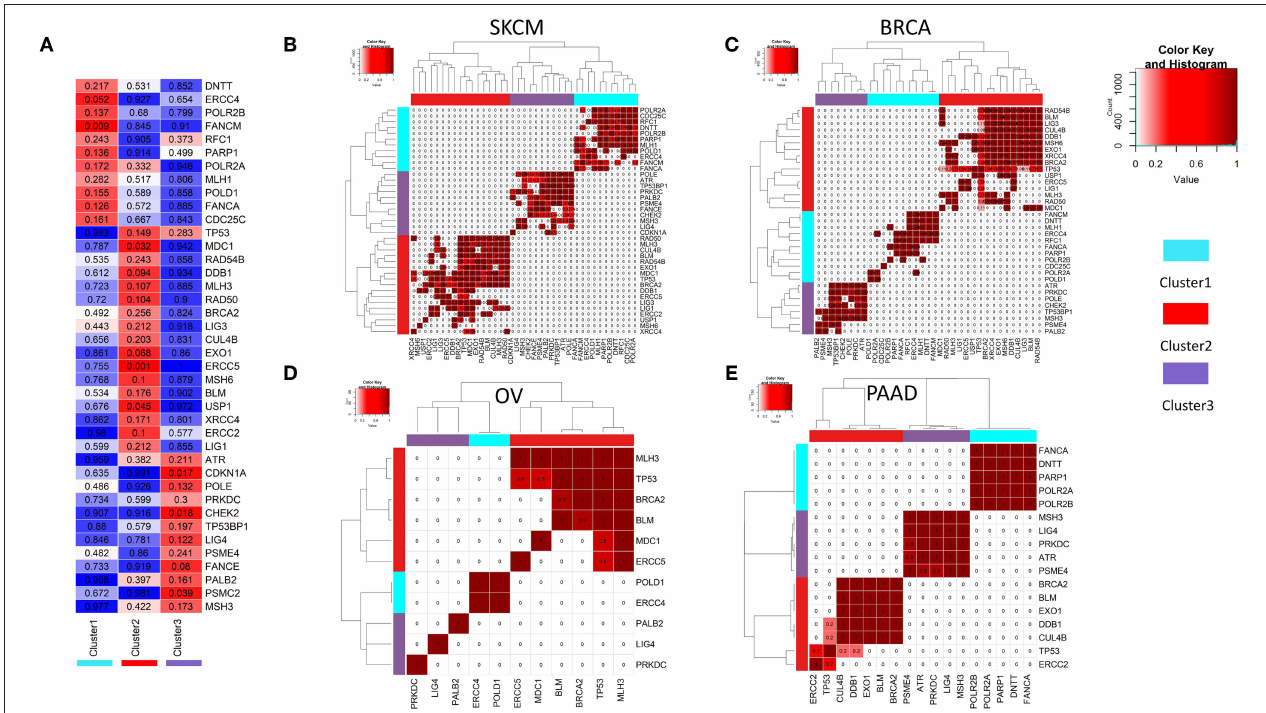
FIGURE 3 | (A) Mutual co-occurrence of certain DDR genes was observed with each of the three DDR clusters identified in 2b. In the matrix, the color key blue to red denotes the tendency from mutual exclusivity to mutual co-occurrence of the corresponding gene mutation (y-axis) and the corresponding DDR cluster (x-axis). The p -values for co-occurrence of DDR gene mutations and DDR clusters calculated using hypergeometric test are shown in each cell. (B–E) Mutually exclusive mutations of DDR genes representing three different DDR clusters (from 3a) is shown for tumor types (B) SKCM (C) BRCA (D) OV (E) PAAD.